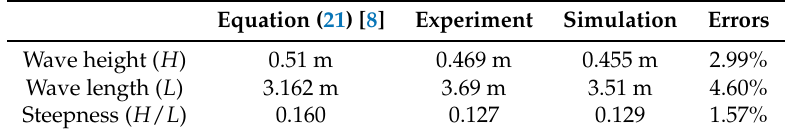
Table 9. Errors in the wave parameters between experiment and numerical results of Case